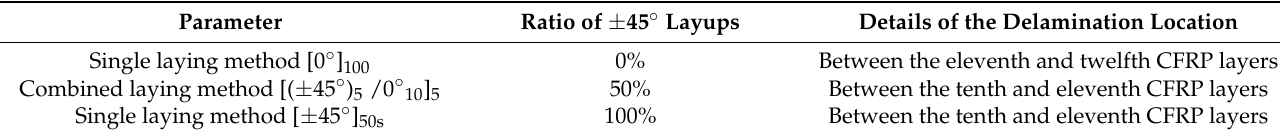
Table 3. Location of first delamination failure under different